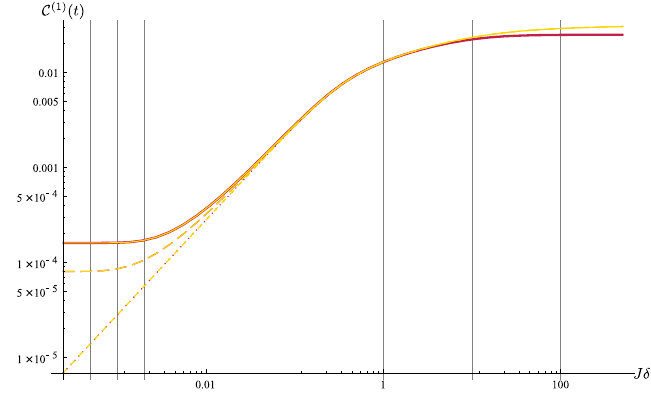
(1) ( t )- Jδt relations in log-log scale when b = 0 . 01. Red and yellow lines correpond Figure 5. Exact C to ECP and CCP-type-like potential respectively. From solid to dashed, the curves correspond to t = 0 . 002 , 0 . 001 and 0 . 0005, respectively. The plots differ at large Jδt (Red plots saturate more quickly).